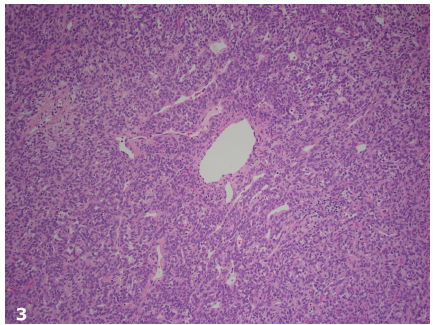
Figure 3: Hypercellular spindle cell neoplasm with hemangio- pericytoma-like vasculature (H&E, original magnification ×